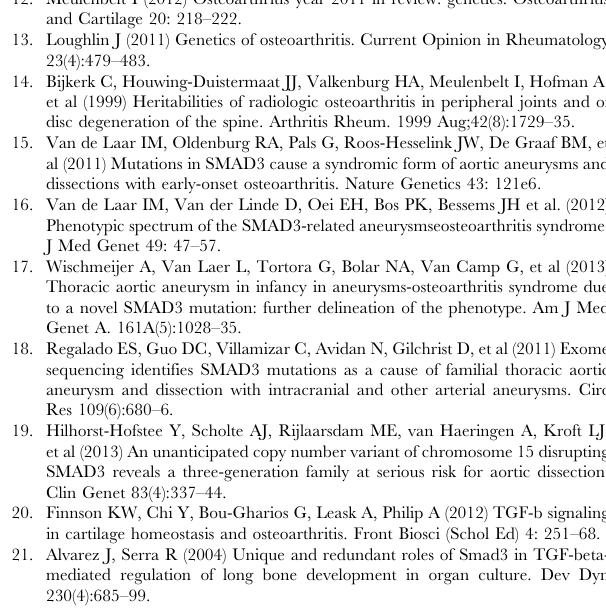
multivariate linear regression for total KL score and each SNP. Table S2 Univariate and multivariate linear regression for total osteophytes score and each SNP. Table S3 Univariate and multivariate linear regression for total JSN score and each SNP. Table S4 Univariate and multivariate logistic regression for GOA and each SNP.